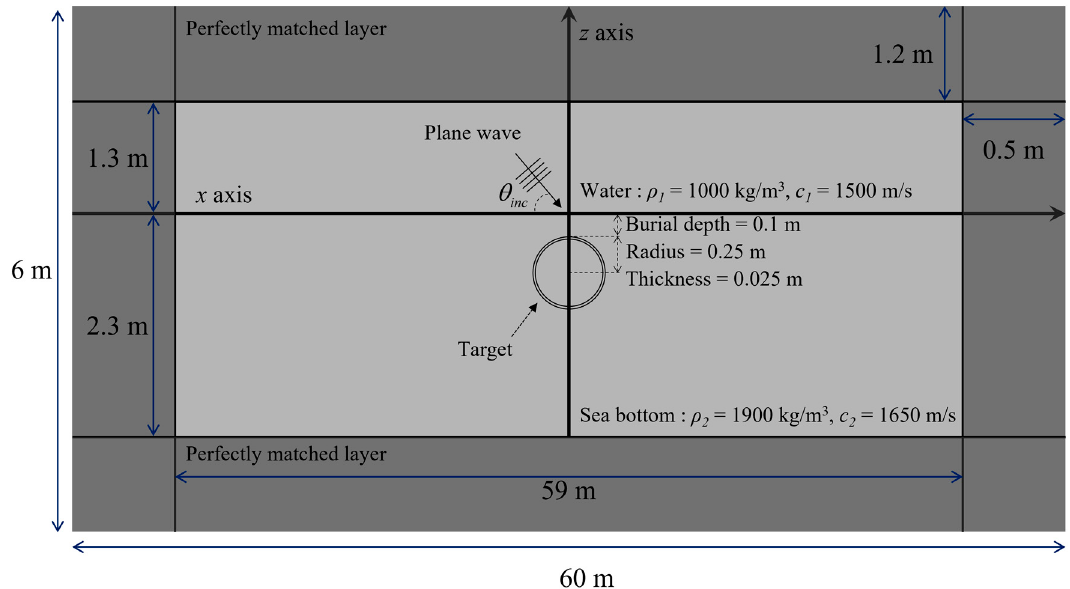
Figure 1. Numerical environment for subcritical scattering from buried target using FEM, where incident angle of θ inc is less than critical angle of θ c . The width and height of FEM are 60 m and 6 m, respectively, and two fluid mediums with the size of 59 m × 3.6 m are surrounded by a perfectly matched layer (PML). The aluminum shell target, whose density and longitudinal and transverse speeds are 2700 kg/m 3 , 6148.9 m/s, and 3097.3 m/s, respectively, is fully buried in the sediment and its inside is filled with air. Triangular and quadrilateral meshes are used for two fluid mediums and PML, respectively, and the mesh size is the one-twelfth acoustic wavelength.